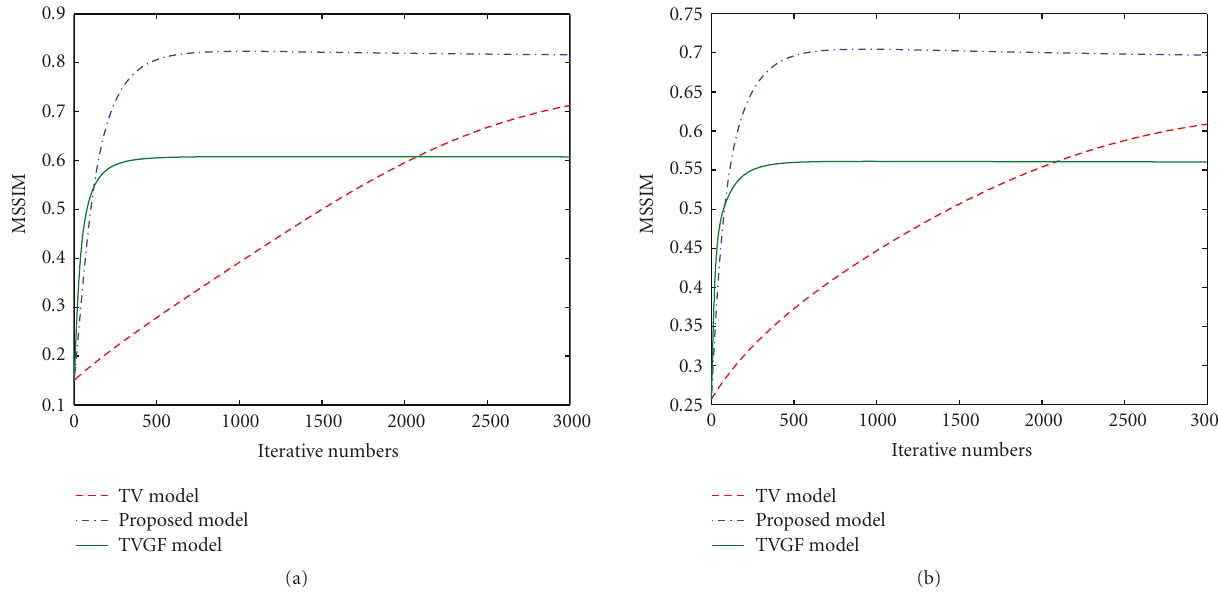
Figure 19: Comparison of the MSSIM results of the di ff erent images which is corrupted by some Gaussian noise of standard deviation 40: (a) “Lena”; (b)